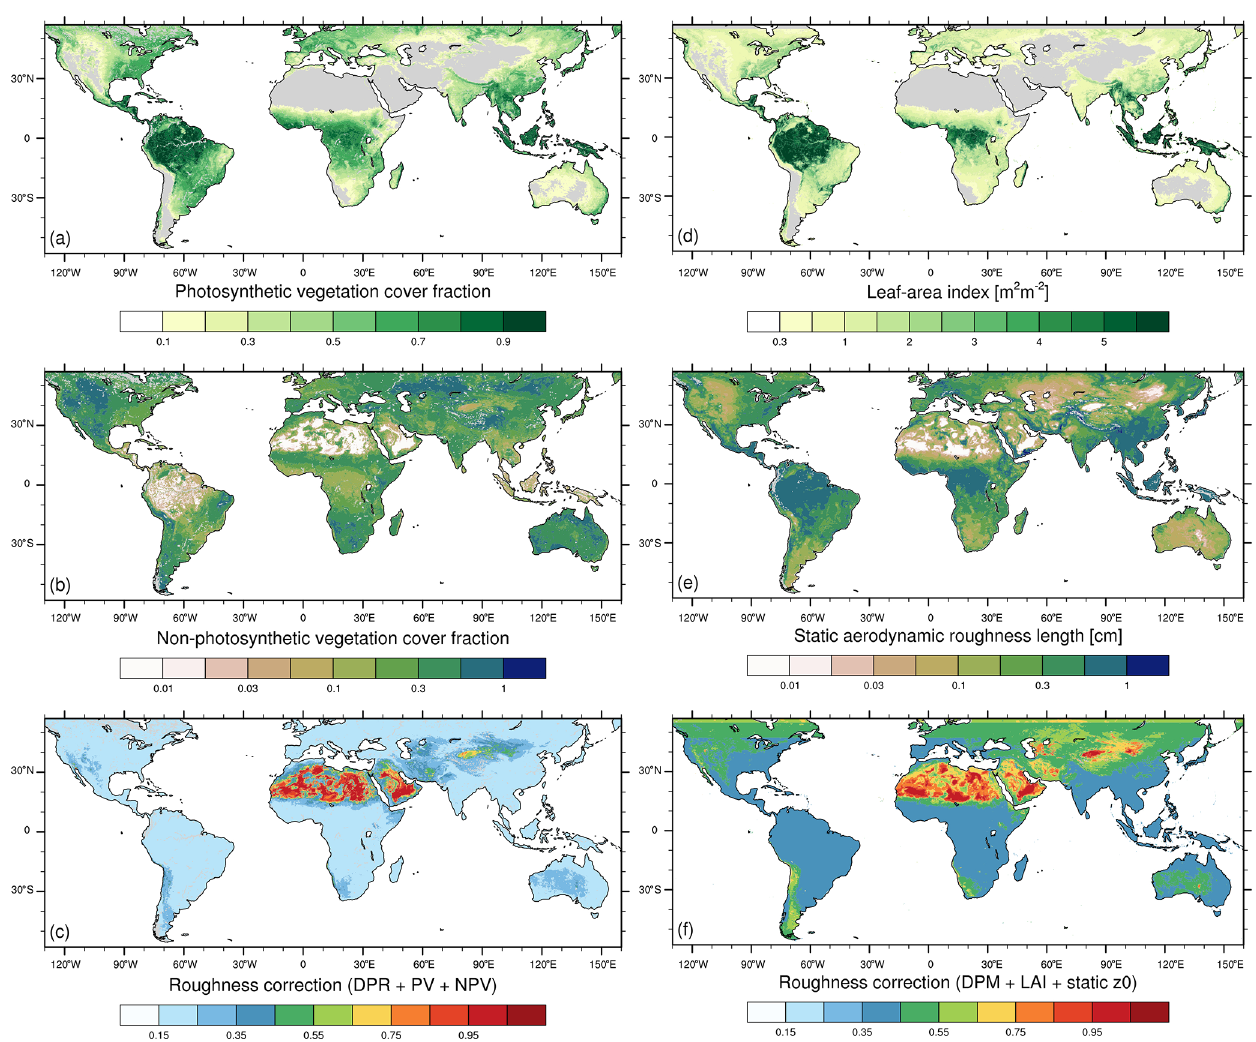
Figure 1. Comparison of roughness input and drag partition approaches: panels (a, b) show, respectively, annual averages for 2012 of photosynthetic and non-photosynthetic vegetation cover fractions (Guerschman et al., 2015), which we use to obtain the roughness correction f v (label DPR) based on Raupach et al. (1993) (parameters c λ = 0 . 2, β = 200, m = 0 . 5, σ = 1) shown in panel (c) ; panel (d) displays the R annual average MODIS leaf area index and (e) static aerodynamic roughness length (Prigent et al., 2012), which we utilize for the roughness correction f v (label DPM) after Marticorena and Bergametti (1995) (parameters z 0s = ( 2 × 650 × 10 − 4 / 30 ) cm, X = 12255 MacKinnon M et al.,